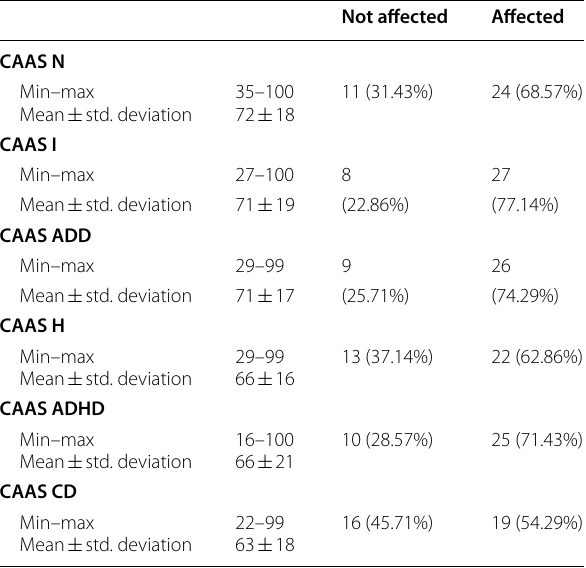
Table 3 Distribution of the studied cases according to the children’s attention and adjustment survey (CAAS) test